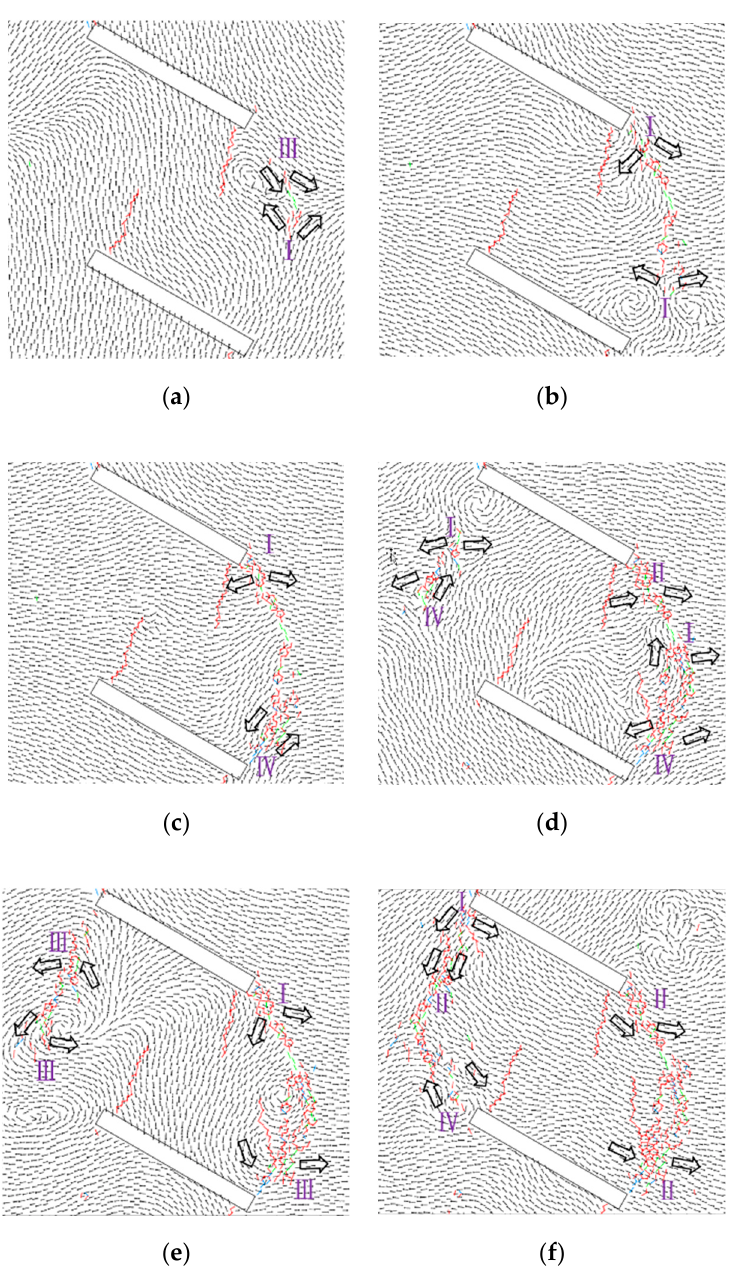
Figure 7. Particle velocity fields at different loading stages. (Pictures a , b , c , d , e and f respectively show particle velocity fields corresponding to different loading stages in Figure 6 when secondary cracks propagate.).